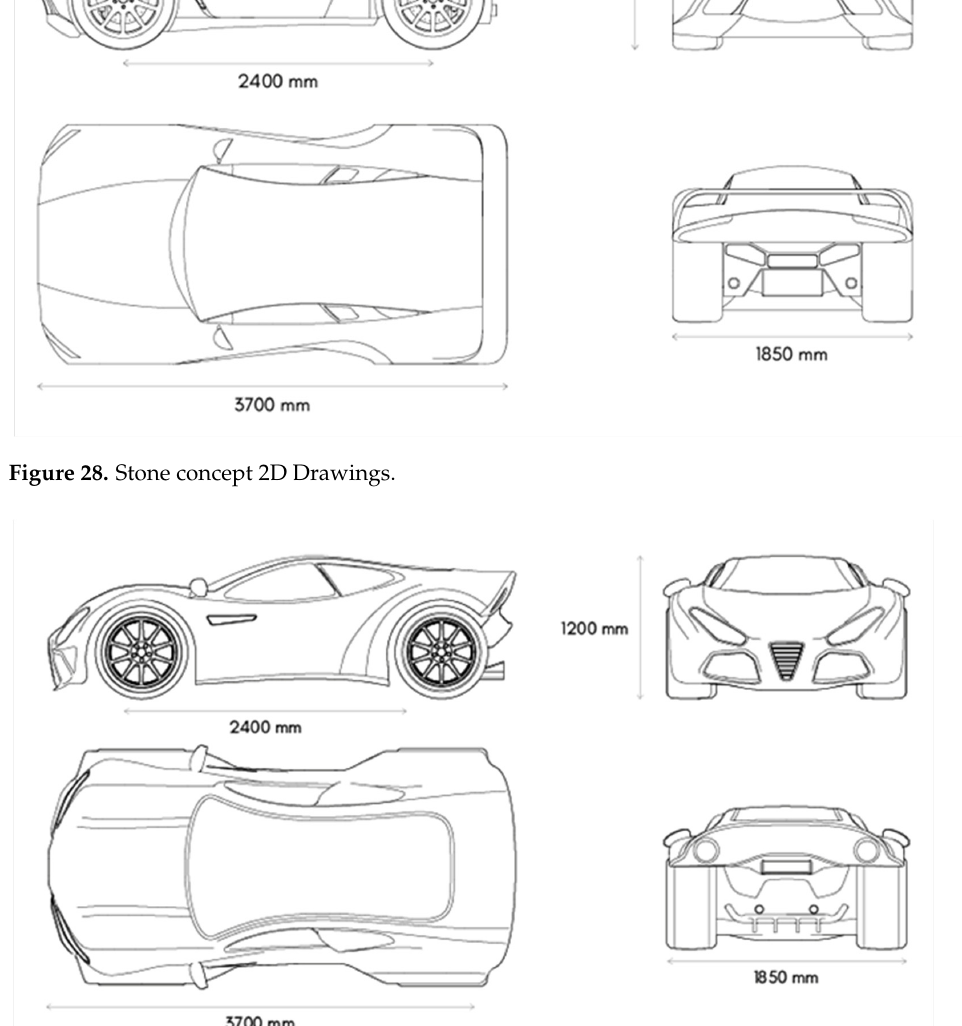
Figure 29. Natural concept 2D Drawings.